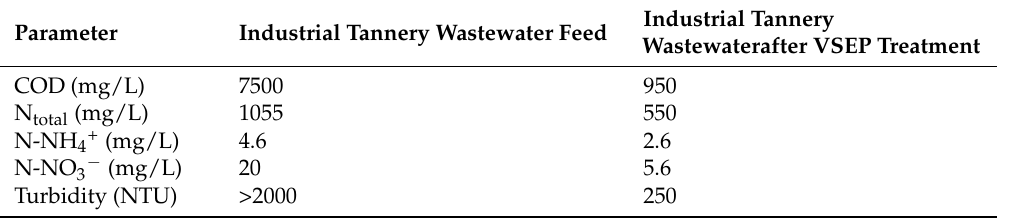
Table 3. Characteristics of real industrial tannery wastewater before and after the application of the VSEP treatment process.